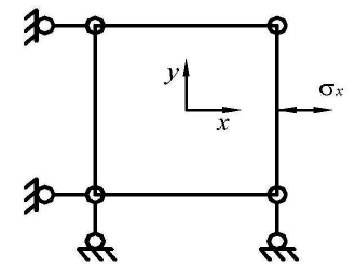
Figure 15. Uniaxial tension of the FEA model.